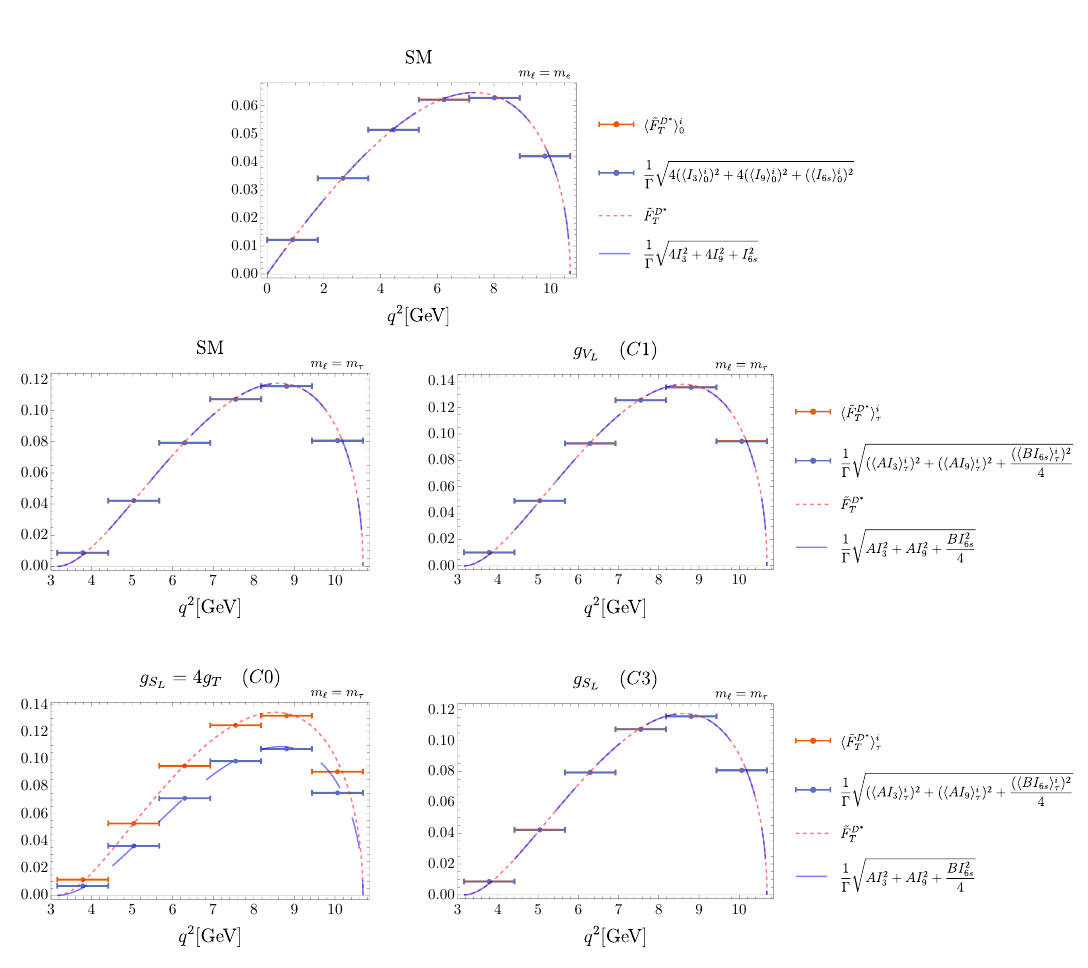
Figure 1. Illustration of the errors induced by binning on the relation in eq. (4.17). The orange dashed curve corresponds to the standard de(cid:12)nition of ~ F D (cid:3) , whereas the blue one corresponds T to ~ F D (cid:3) alt . The orange bins in this plot are obtained using the binning form of the \standard" T expression for ~ F D (cid:3) while the blue ones are obtained using the approximate binned expression of T ~ F D (cid:3) alt in eq. (4.17). The plots labelled SM correspond to the case m ‘ = m e and m ‘ = m (cid:28) in the T SM and the other plots correspond to ~ F D (cid:3) in B ! D (cid:3) (cid:28)(cid:23) in di(cid:11)erent NP scenarios described in the T text. The di(cid:11)erences come from the presence of tensor currents for ( C 0) or from binning e(cid:11)ects for the SM